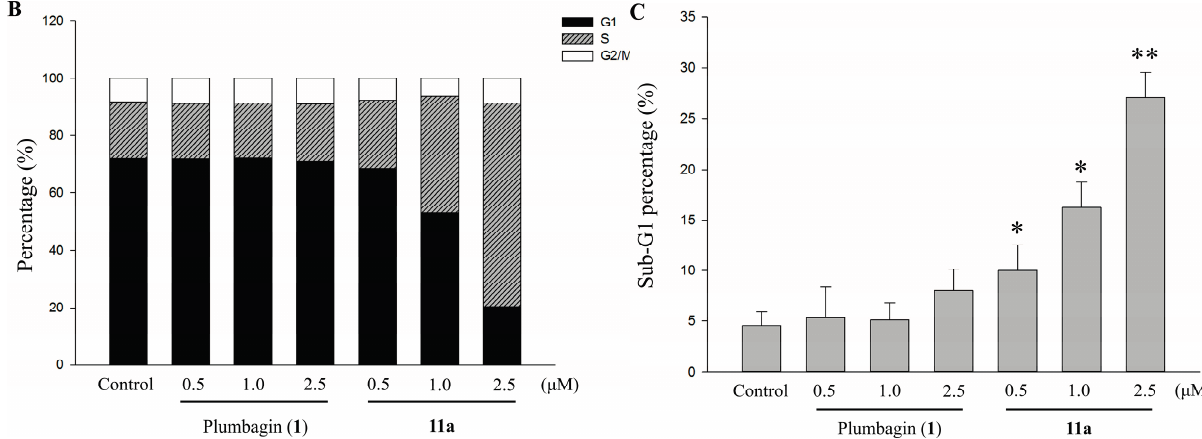
Figure 3. ( A ) The effects of the 48 h treatments with 0–2.5 μ M plumbagin ( 1 ) and 11a on cell cycle distribution of HT-29. After treatment, cells were fixed and stained with PI, and the cell cycle distribution was examined by flow cytometry; ( B ) Quantitative data of cell cycle analysis of HT-29 treated with 0 ‒ 2.5 μ M plumbagin ( 1 ) and 11a for 48 h; ( C ) Compared with control, the treated with plumbagin ( 1 ) and 11a shows the obvious increase in sub-G1 fraction. Each value represents the mean ± SD of three independent